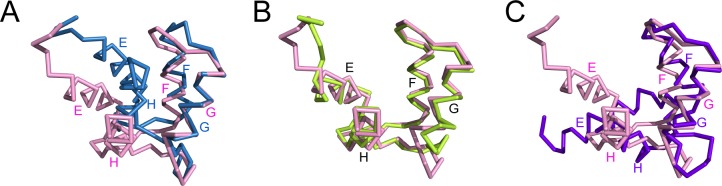
The C-lobe of CaM in the SidJ-CaM complex adopts a semi-open conformation.(A) A structural comparison of the CaM C-lobe in the SidJ–CaM complex (pink) with apo-CaM (blue) (PDB ID: 1CFC). (B) Structural overlay of the CaM C-lobe in the SidJ-CaM complex (pink) with CaM C-lobe (green) bound to the first IQ-motif in the myosin V-CaM complex (PDB ID: 2IX7). (C) A structural comparison of the CaM C-lobe in the SidJ–CaM complex (pink) with that (purple) in Ca2+ fully chelated CaM (PDB ID: 1CDL). The structures are overlaid in reference to helices F and G.